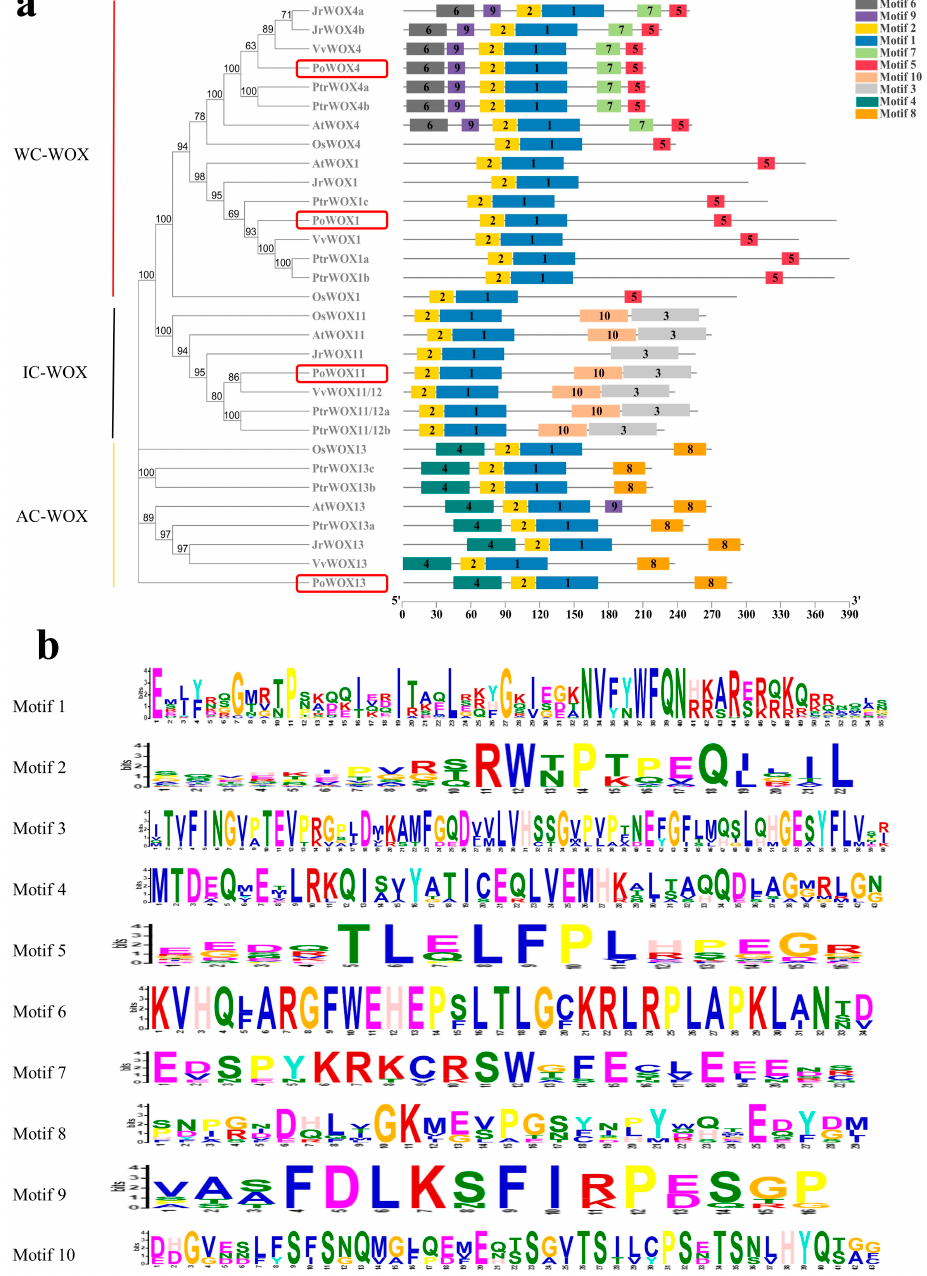
Figure 3. Conserved motif analysis of WOX proteins and sequence identification of ten conserved motifs. ( a ) the phylogenetic tree and conserved motif analysis of six species ( A. thaliana, O. sativa, P. suffruticosa, J. regia, V. vinifera , and P. trichocarpa ), the red rectangle circles the peony PoWOX protein. A total of ten conserved motifs were identified, and each motif was represented by a separate number and color. Blue motif 1 represents HD, red motif 5 represents that the WUS motif is only present in the WC-WOX, yellow motif 2 is present in every clade, dark gray motif 6 and light green motif 7 are unique to WOX4 protein, purple motif 9 is present in the WOX4 subclade and AtWOX13, orange motif 10 and light grey motif 3 belong to the IC-WOX, and dark green motif 4 and orange motif 8 exist alone in the AC-WOX. ( b ) Sequence identification of the predicted 10 motifs of WOX protein.